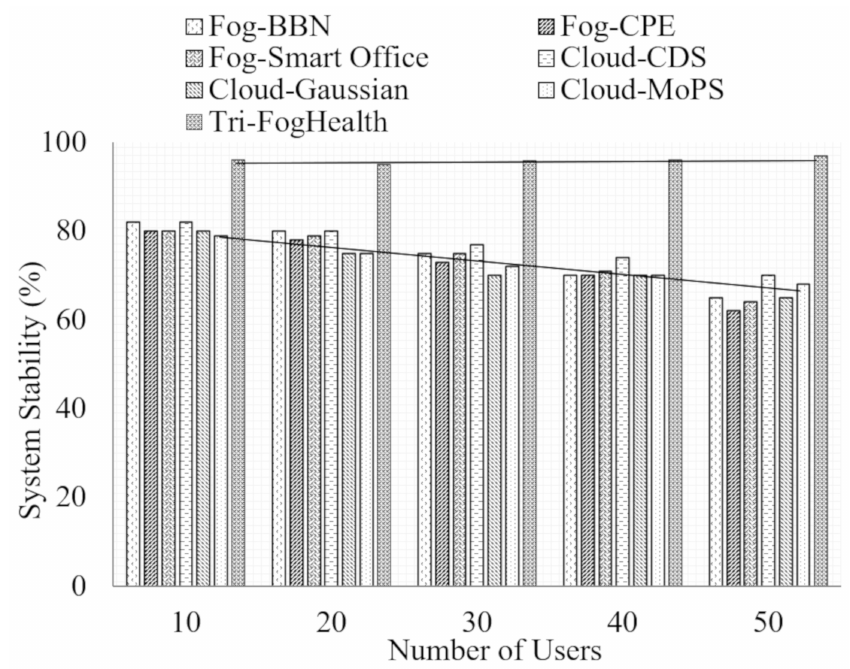
Figure 15. Comparison of System Stability based on Number of